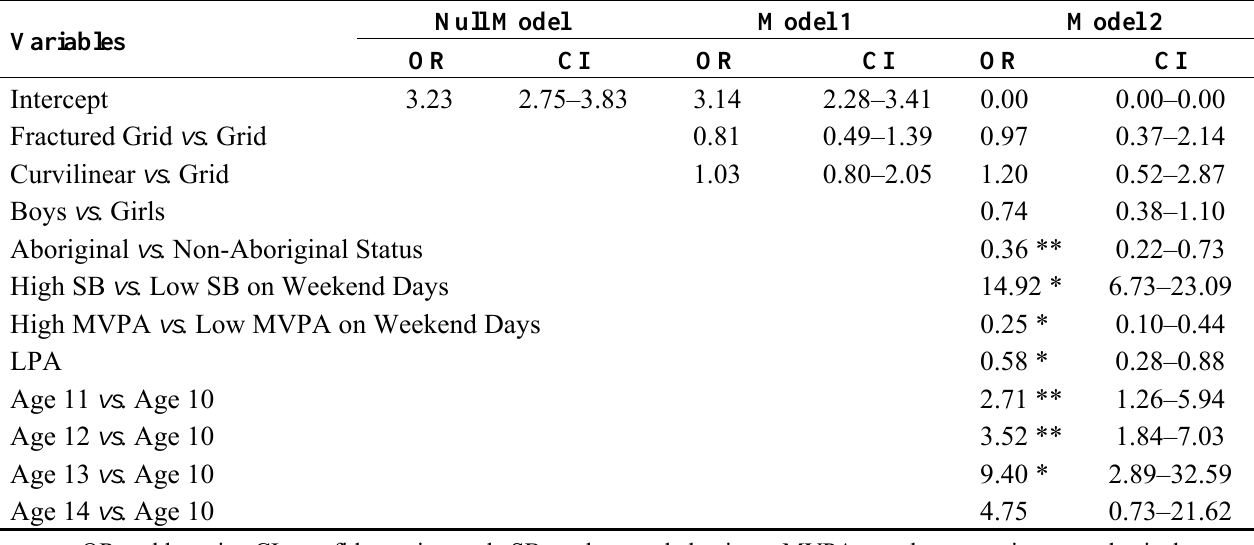
Table 4 Multilevel logistic regression model predicting SB accumulation (mean daily SB ≥ 480 vs. <480 minutes)